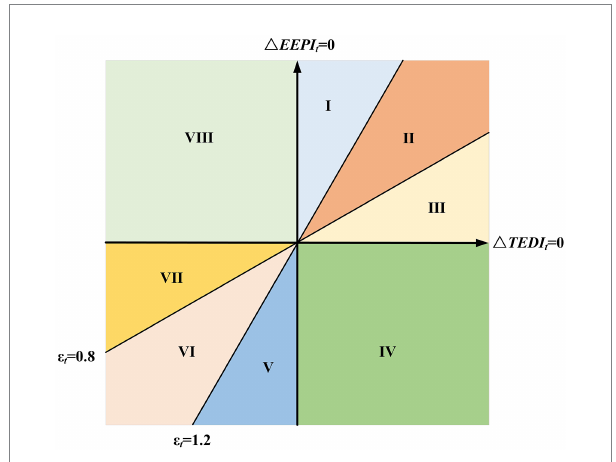
FIGURE 4 The division standard of decoupling type between tourism economic and ecological